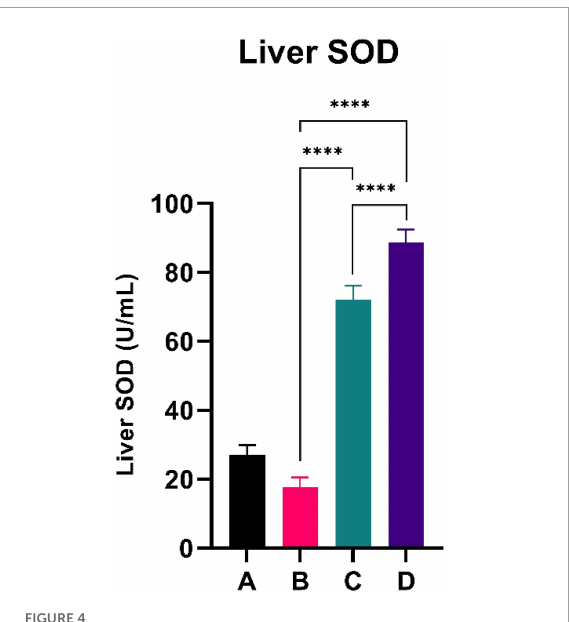
FIGURE4 Both doses of sea grapes have a significant effect on liver SOD activity. ****Means a strong p -value of <